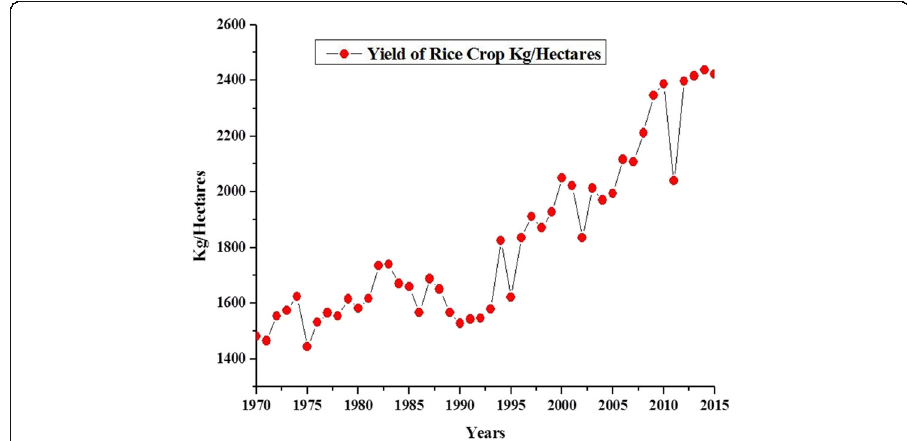
Table 1 Results of ADF unit root test including (trend and intercept) Variables At level First difference LnAGR − 2.123963 LnOPRICE − 4.327917* LnARRICE − 6.570315* LnWA − 1.812550